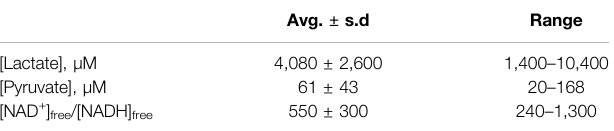
TABLE 4 | Cellular concentrations of lactate, pyruvate, and ratios of [NAD + ] free / [NADH] free , from (Schwartz et al.,